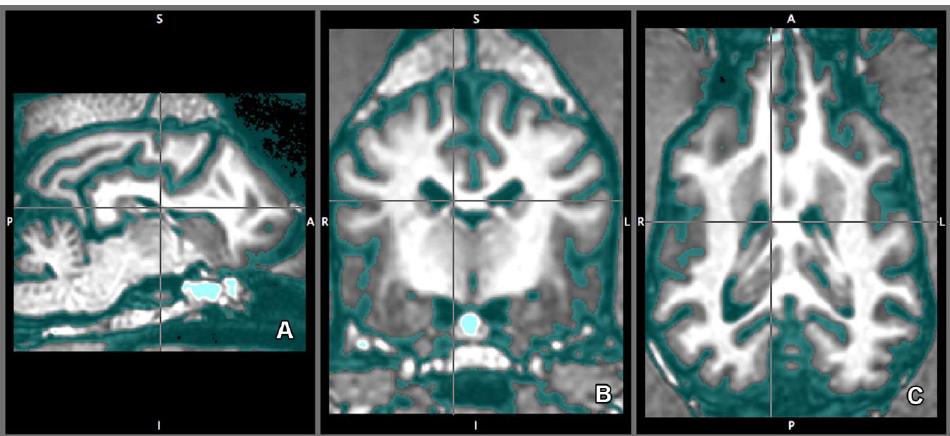
Figure 3. Cerebrospinal fluid (CSF) template of the brain. CSF segmentation on the sagittal ( A ), transverse ( B ), and on the dorsal plane ( C ). On CSF template of the software, the area highlighted in blue signifies the CSF or any other tissue that has the same intensity value. That includes the lateral ventricles. Directions are referred as superior (S), inferior (I), posterior (P), anterior (A), left (L) and right (R).